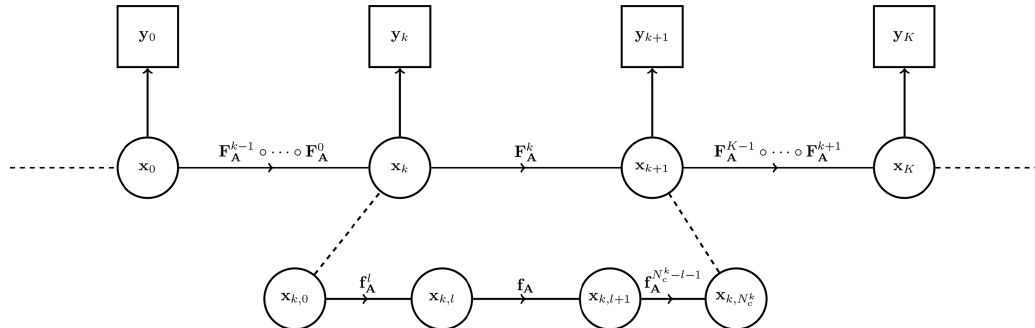
Figure 1. Representation of the data assimilation system as a hidden Markov chain model and of the model resolvents F k